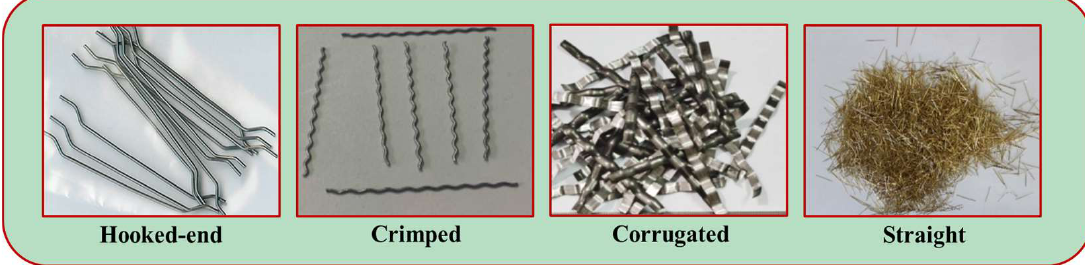
Figure 6. Typical types of steel fiber.